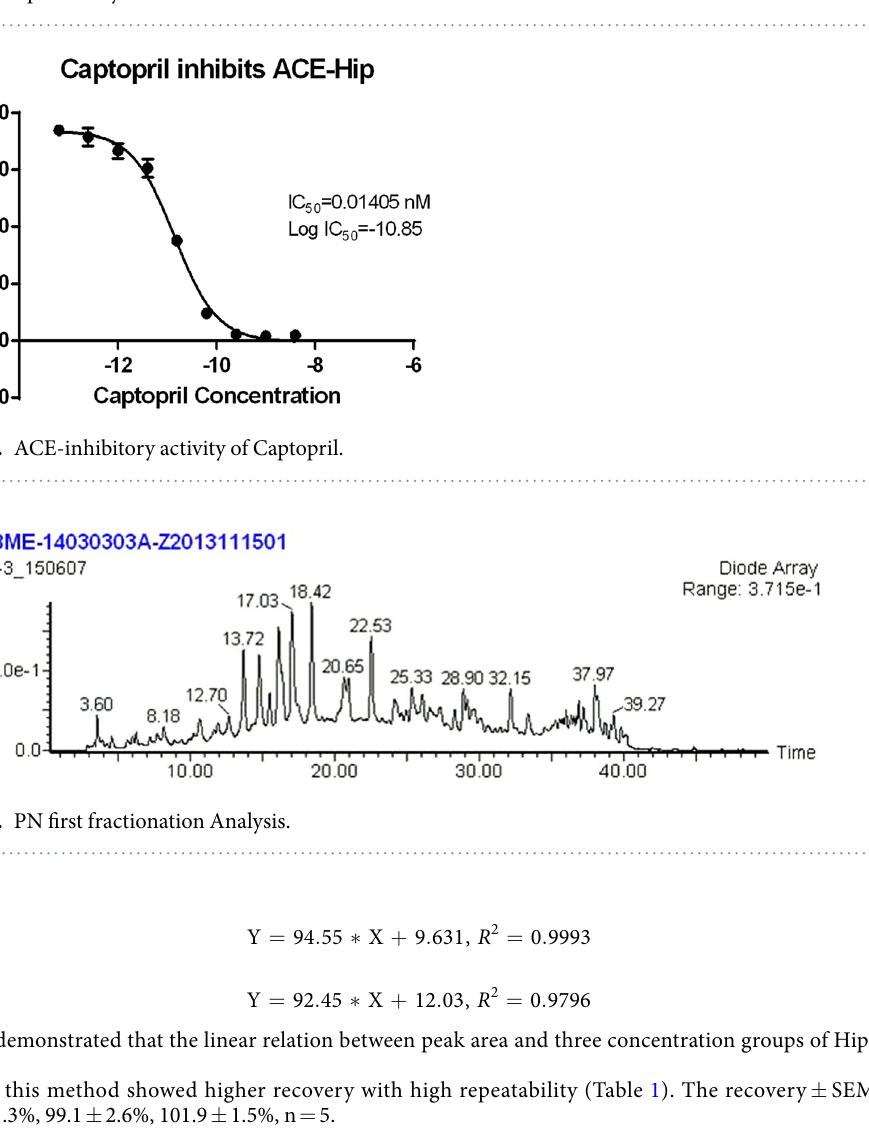
Table 1. Repeatability of the method.